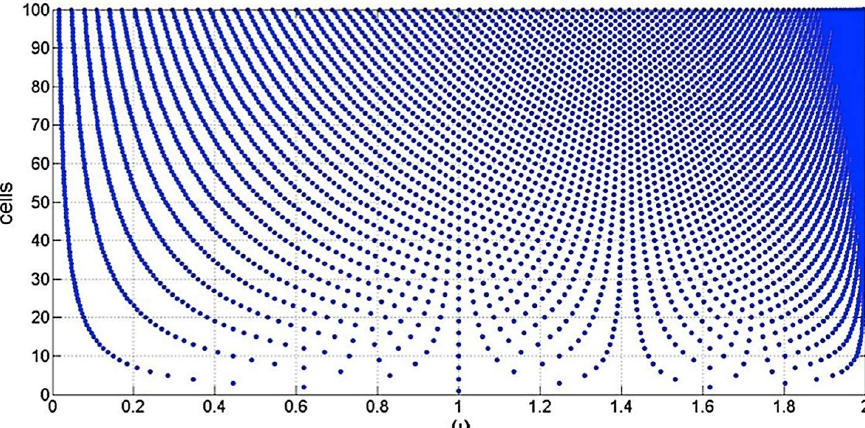
Figure 1. Normalized ω solutions in the case of an inductor–capacitor (L–C) ladder network (L.N.) formed by a number of single cells from 1 to 100.